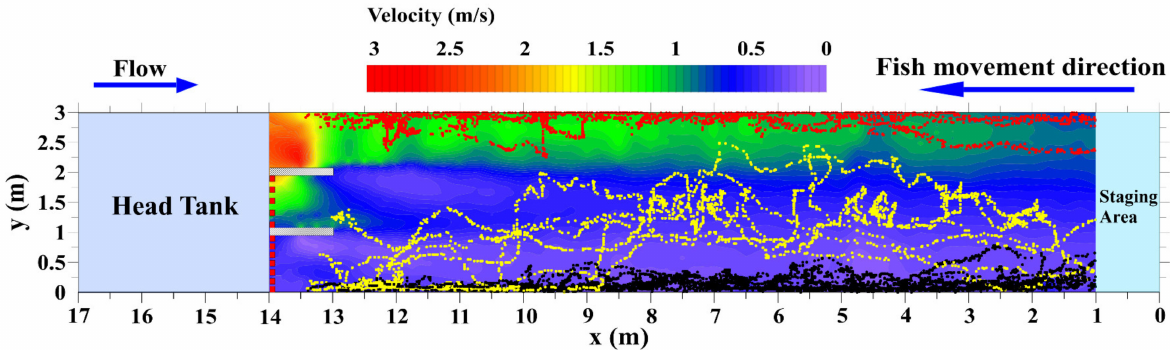
Figure 4. Superimposed diagram of typical swimming trajectories of individual S. prenanti on the contour line of flow velocity